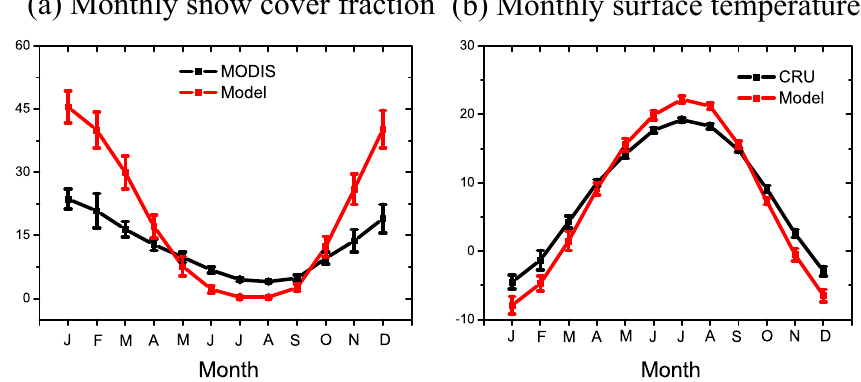
Figure 3. (a) Monthly snow cover fraction (%) from MODIS and the CAM4-BAM model; (b) monthly surface temperature ( ◦ C) from CRU and the CAM4-BAM model over the Tibetan Plateau (25–45 ◦ N, 70–110 ◦ E), where the error bars represent the standard deviation of the corresponding